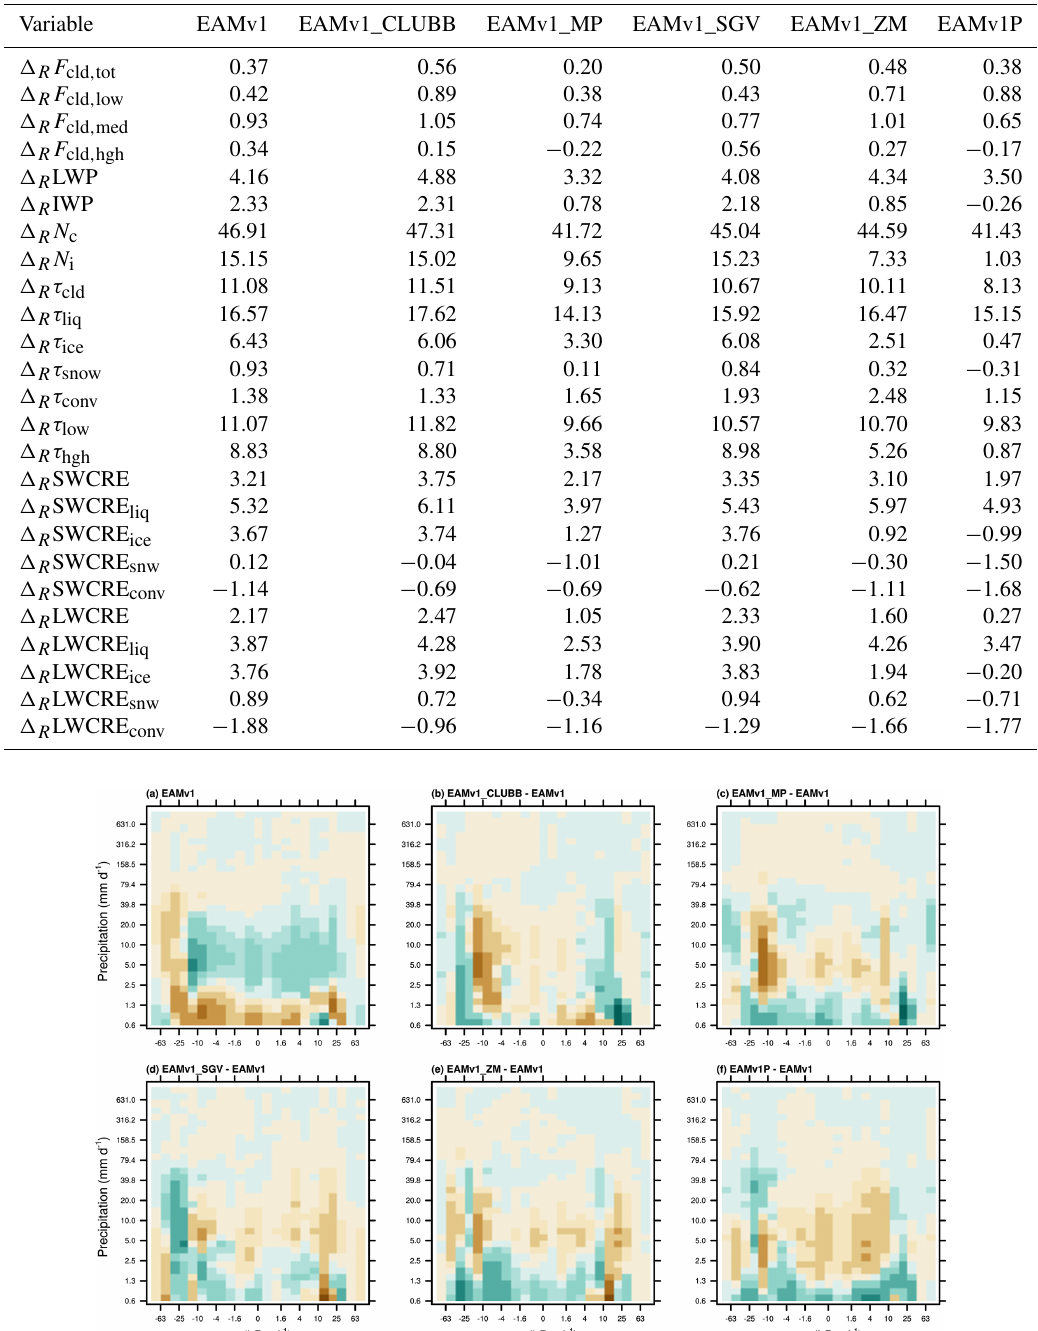
Table 10. The same as Table 6 but instead showing the change in cloud properties induced by anthropogenic aerosols relative to their pre-industrial values (unit = %). Variables are defined in Table 6.